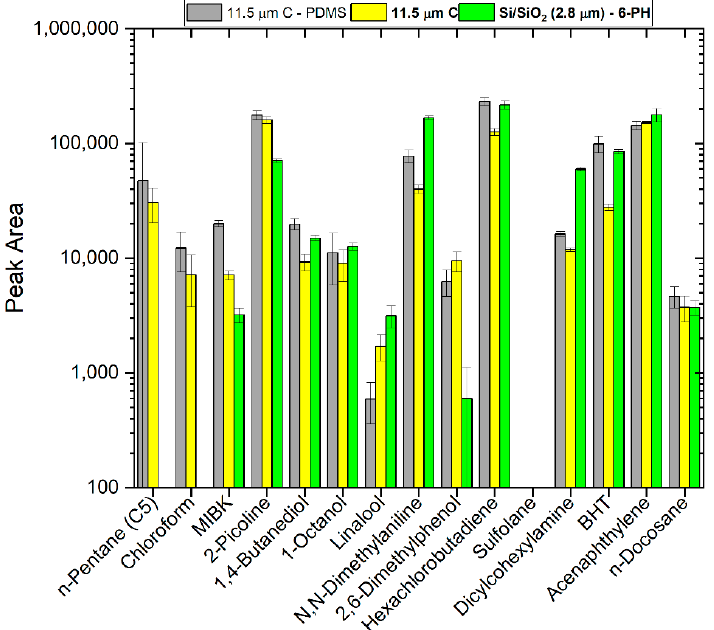
Figure 7. DI – SPME – GC – MS results for 11.5 µm sputtered carbon SPME fibers and a 2.8 µm sputtered silicon SPME fiber. n = 3 for each compound, and y-error bars represent standard deviations.